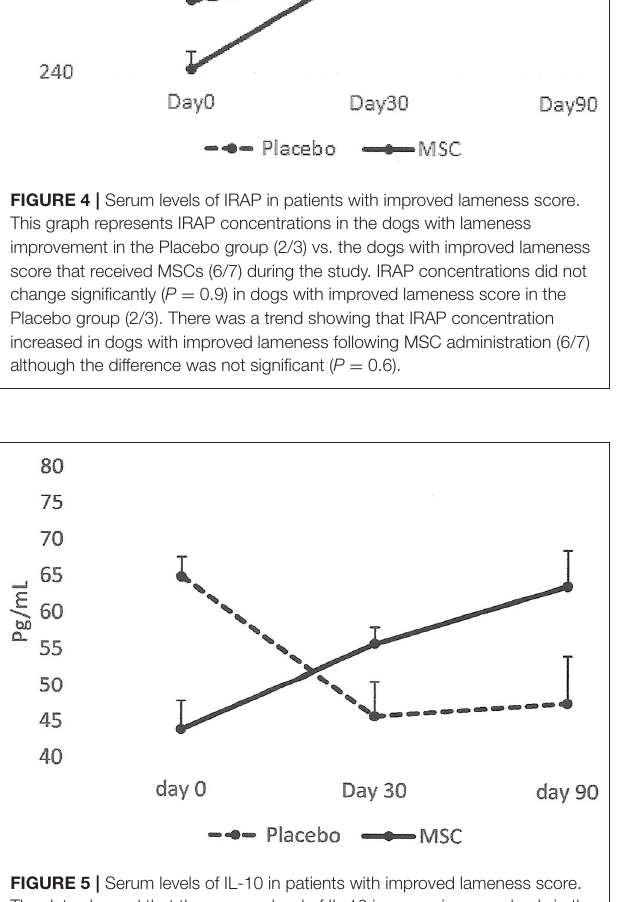
FIGURE 5 | Serum levels of IL-10 in patients with improved lameness score. The data showed that the average level of IL-10 in serum increased only in the dogs treated with MSCs (4/6) and remained high at day 90. On the contrary, serum levels of IL-10 diminished in dogs in the Placebo group and